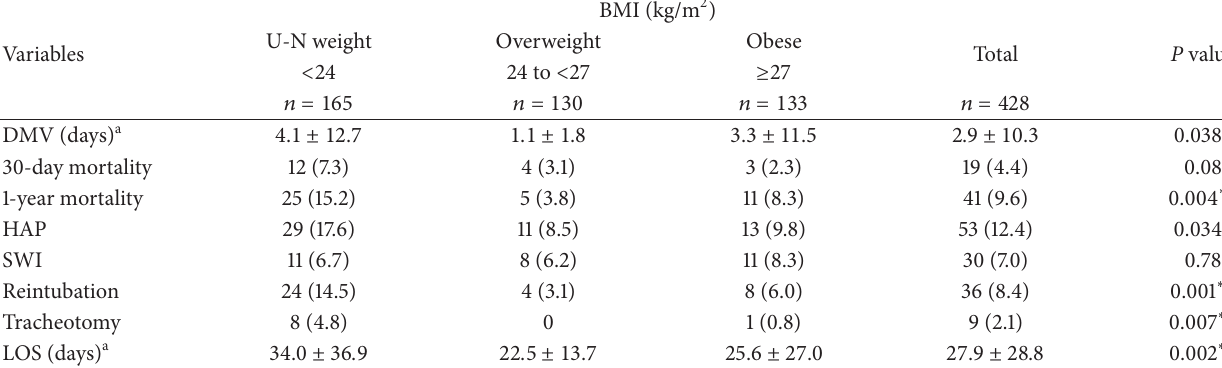
Table 3: Comparison of the outcome markers in the BMI